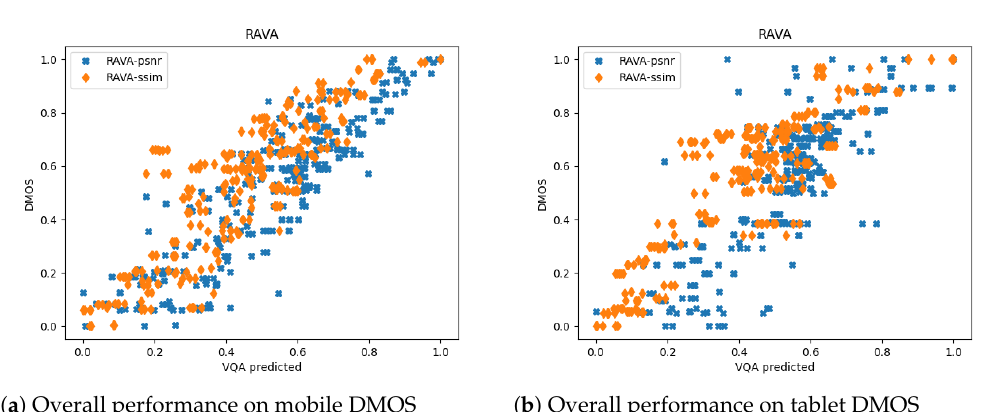
Figure 11. The overall performance of the RAVA models on the Live Mobile Database (mobile and tablet).